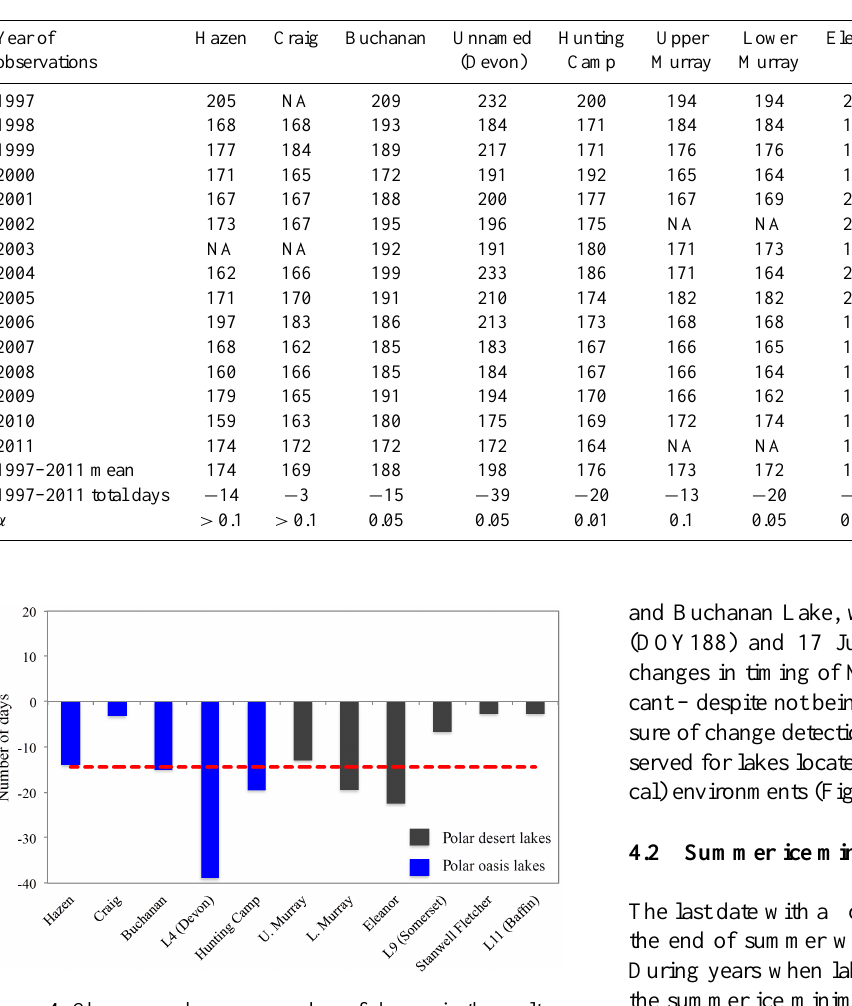
Table 3. Melt onset dates shown as day of the year (DOY) for the studied lakes from 1997 to 2011. Missing values (NA) indicate the lack of available satellite imagery. Total days for each individual lake refer to the total number of days change during the 1997–2011 period and are reported to the mean melt onset DOY of the same period. The statistical significance is indicated by the α values.